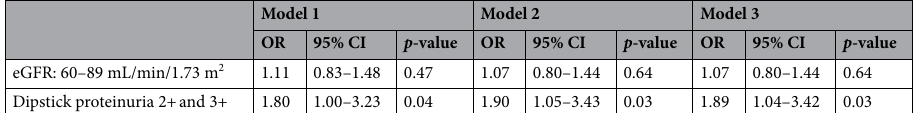
Table 2. Multivariable logistic regression analysis for stage 2 chronic kidney disease and proteinuria with localized periodontitis in young adults. Data are presented as odds ratios (OR) and 95% confidence intervals (CI) using multiple logistic regression analysis models. Model 1: age, sex, alcohol intake, smoking and education level adjustments. Model 2: age, sex, alcohol intake, smoking, education level, BMI, mean blood pressure, fasting glucose, total cholesterol and serum triglycerides. Model 3: age, sex, alcohol intake, smoking, education level, BMI, mean blood pressure, fasting glucose, total cholesterol and serum triglycerides and remaining teeth. CKD chronic kidney